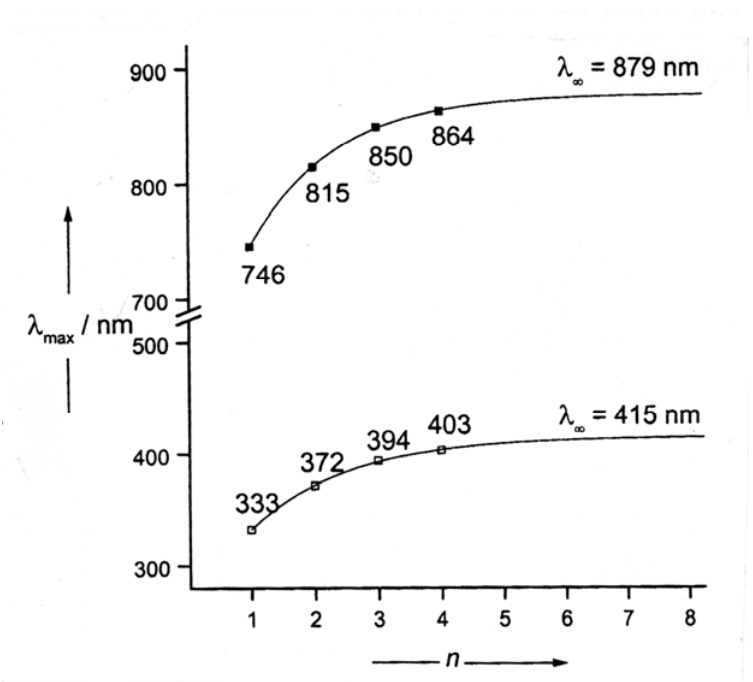
/CF CO H, 7:3) 3 3 2